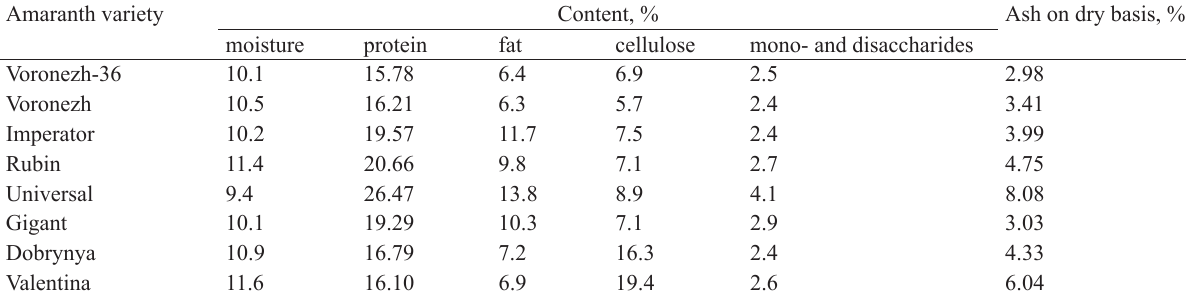
Table 1 Amaranth grain